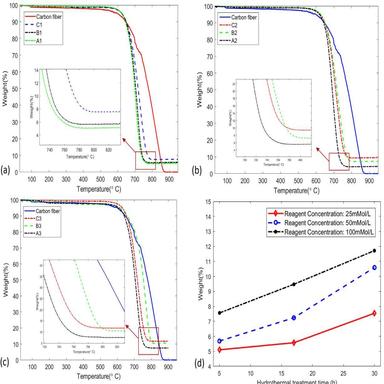
TGA characterization of ZnO weight concentrations in hybrid structural fibers.